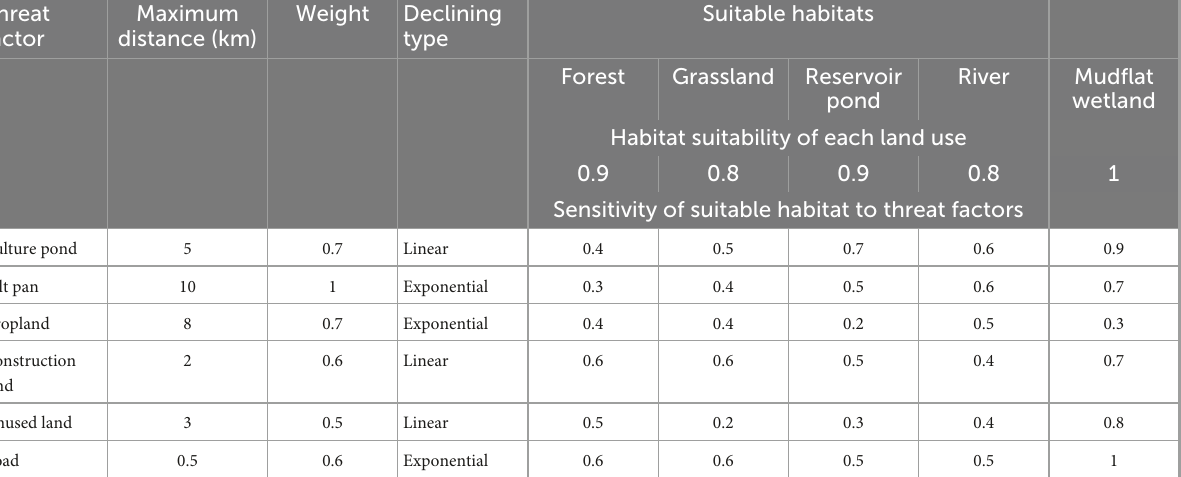
TABLE 2 Input data used for the InVEST-habitat quality